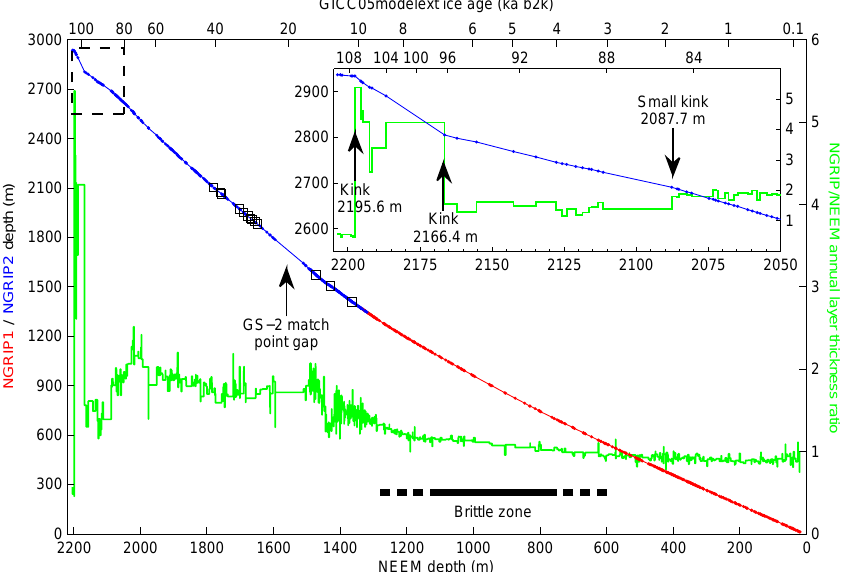
Fig. 4. ECM/DEP-based match points between the NEEM and NGRIP1 (red) and NGRIP2 (blue) ice cores and the tephra horizons (black squares). In green (right axis), the NGRIP/NEEM annual layer thickness ratio r ab is shown. The insert shows the details of the match points and r ab over the lowest 150m of the core, where kinks in the (NEEM depth, NGRIP depth) relation and corresponding jumps in r ab most likely indicate areas subject to differential